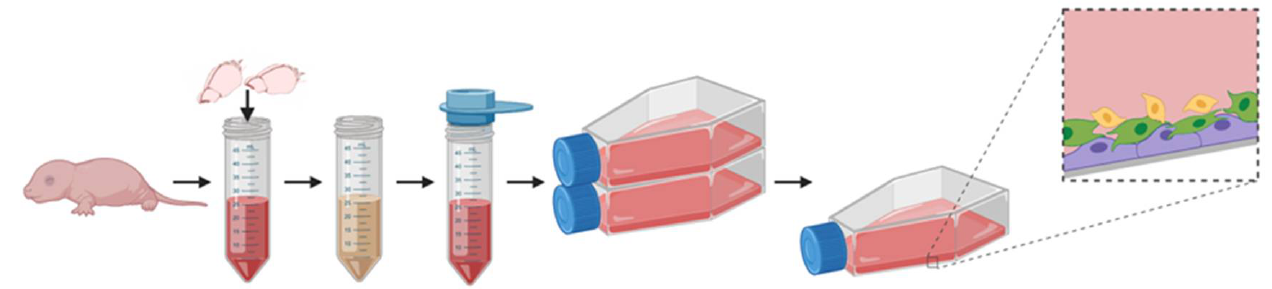
Figure 2. The scheme of establishing primary mixed glial cells from the brains of neonatal rats for the purpose of obtaining the three main types of glial cells. Figure created with BioRender.com. (accessed on 1 April 2022).